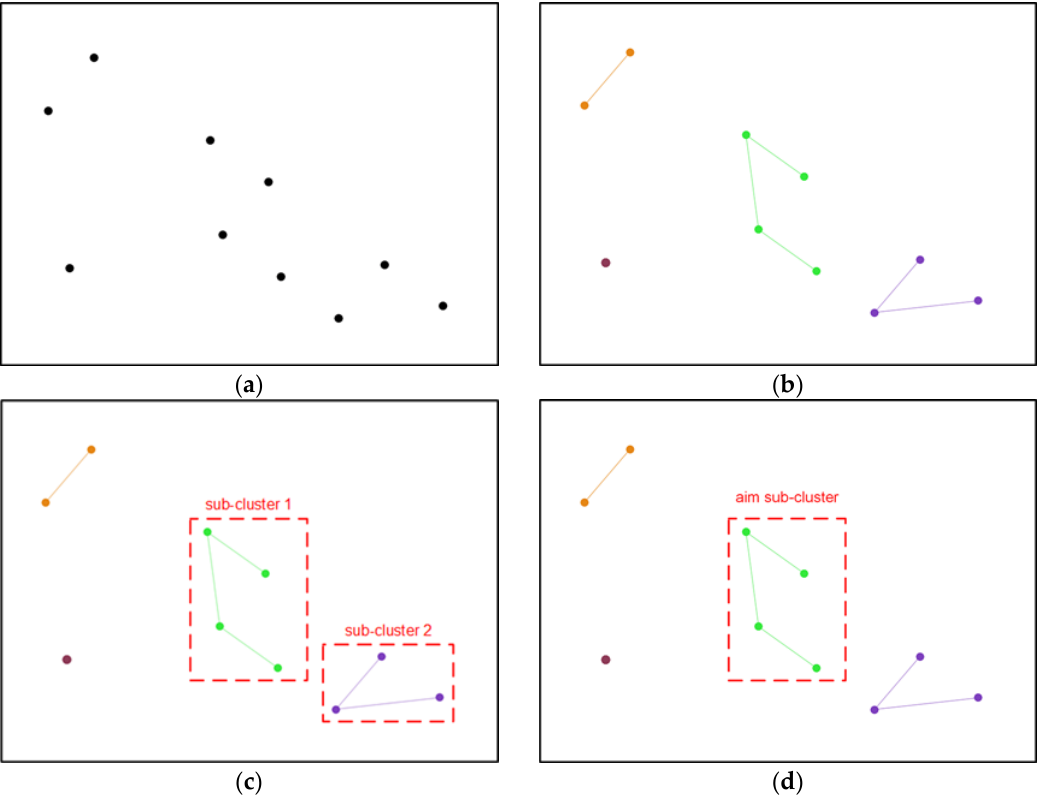
Figure 3. The illustration of the proposed AWKNN localization algorithm, ( a ) get 10 initial RPs from the selected cluster by KNN; ( b ) 4 sub ‐ clusters are divided by APC and illustrated in different colors; ( c ) select 2 sub ‐ clusters with top number of points; ( d ) obtain the aim sub ‐ cluster by the comparison of signal ‐ domain distance between sub ‐ cluster center and the online RSS readings.